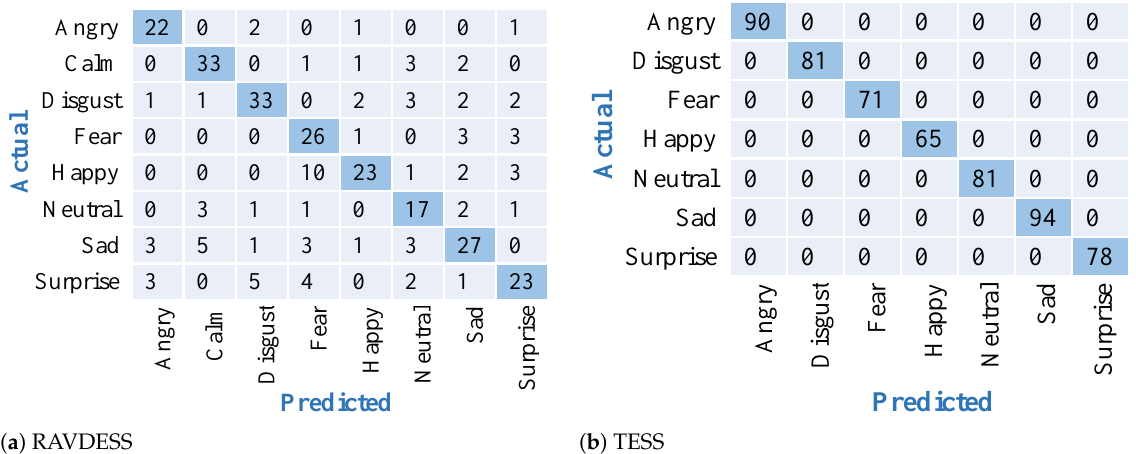
Figure 4. Confusion matrices for feature extraction and modeling using DNN over 2 datasets. Diagonal elements with dark blue color show accurately predicted classes.